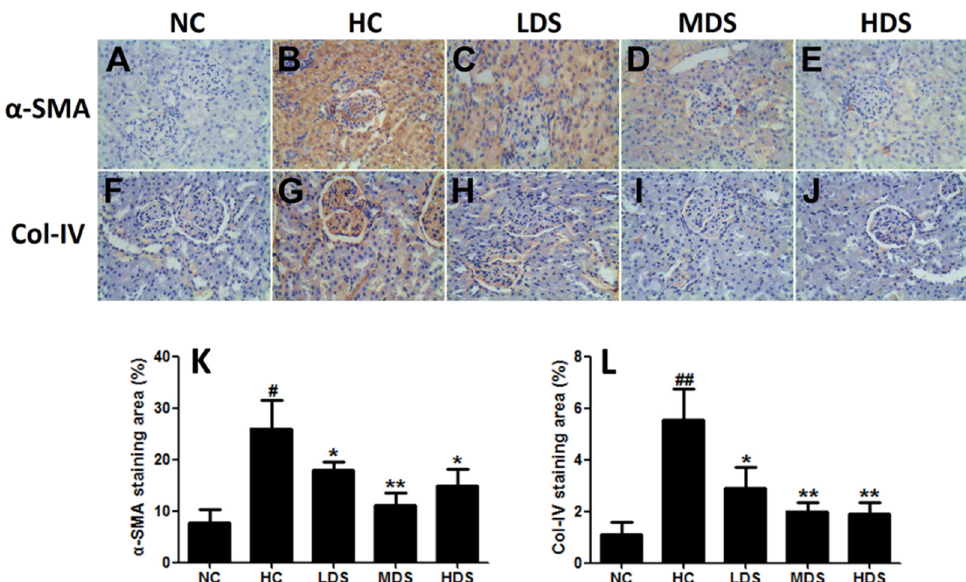
Figure 4. Immunohistochemical staining of α‐ SMA ( A – E ) and Col ‐ IV ( F , G ) expression of renal sections in the NC group ( A , F ) HC group ( B , G ) LDS group ( C , H ) MDS group ( D , I ) and HDS group ( E , J ) (magnification ×400). Quantification of α‐ SMA ( K ) and Col ‐ IV ( L ) staining, evaluated with Image ‐ Pro Plus software (Media Cybernetics, Silver Springs, MD, USA). # p < 0.05, ## p < 0.05 compared with the NC group; * p < 0.05, ** p < 0.01 compared with the HC group.